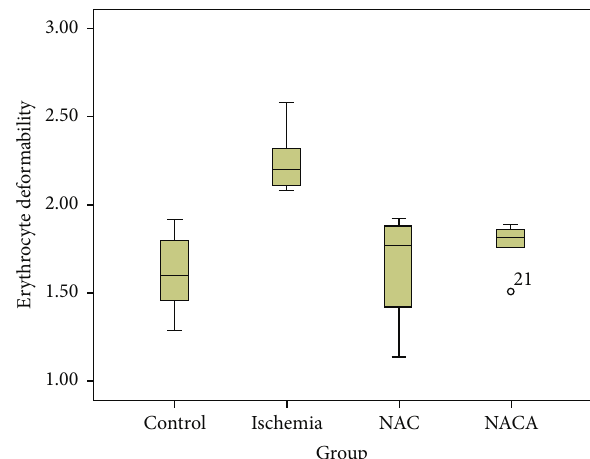
Figure 2: Error bar graph showing erythrocyte deformability distributions in groups with 95% confidence